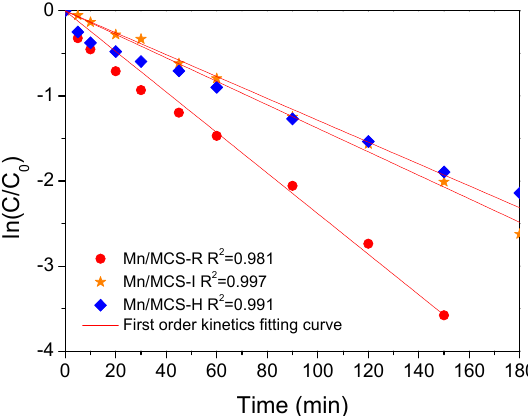
Figure 8. First order kinetic model of reactions. Y axis values are referred to the residual phenol.